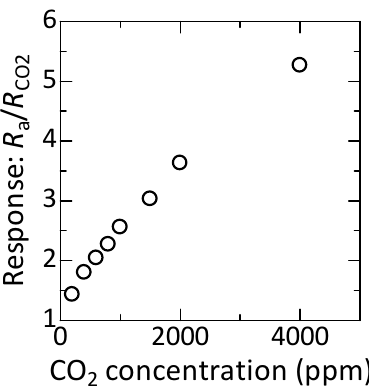
Figure 8. CO 2 concentration dependence of the response at 400 ◦